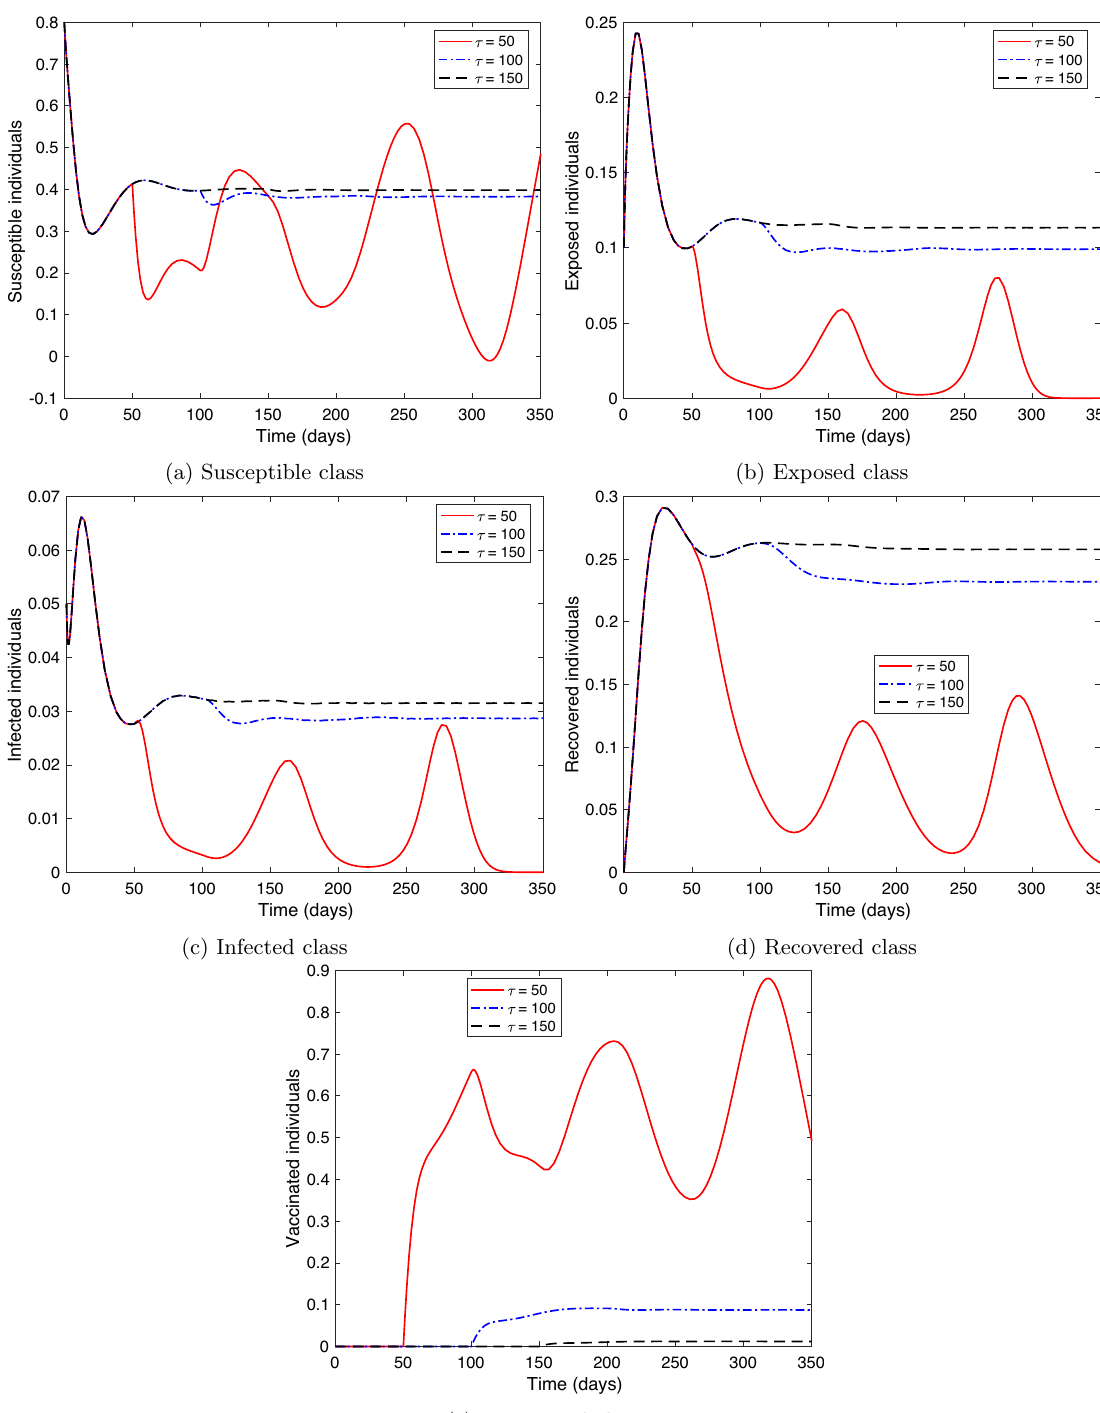
Figure 6. Numerical solution of system (25) versus time with different values for the time delay τ